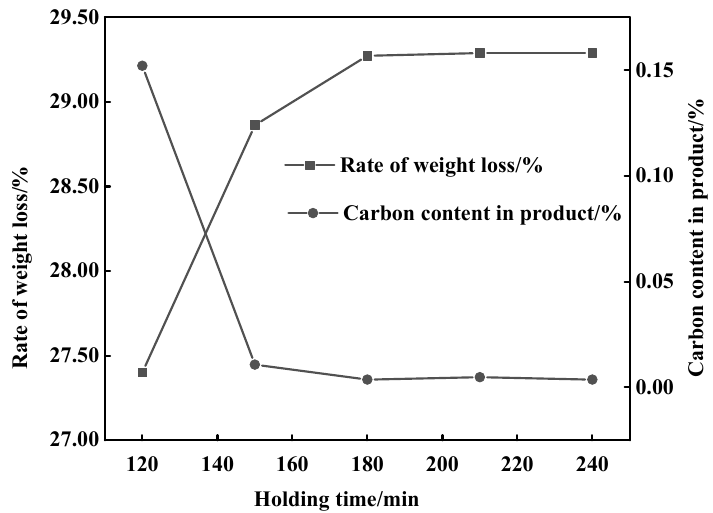
Figure 11. Rate of weight loss and carbon content in sample reduced at 10 −4 Pa and 1200 °C.